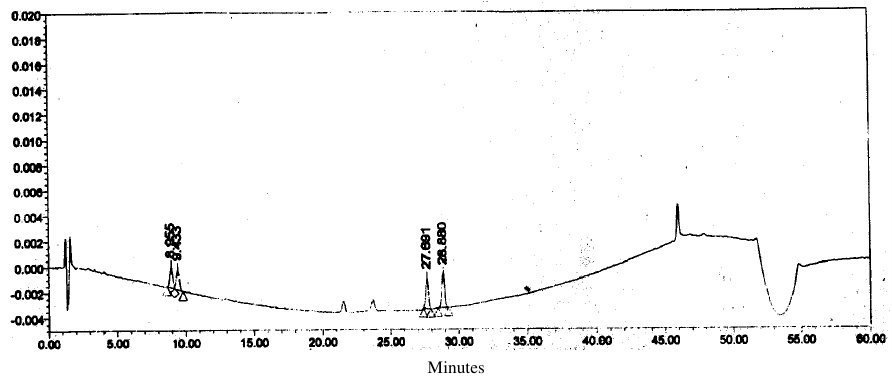
Figure 6. Chromatogram of Impurities with standard montelukast sodium Linearity Plot